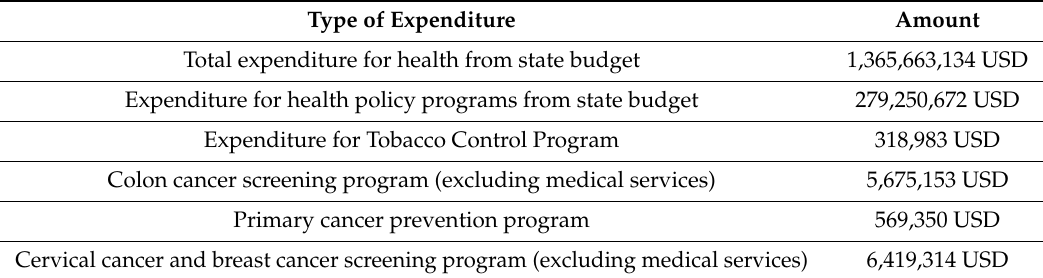
Table 4. Comparison of the funds for selected health interventions in Poland (2013) 1